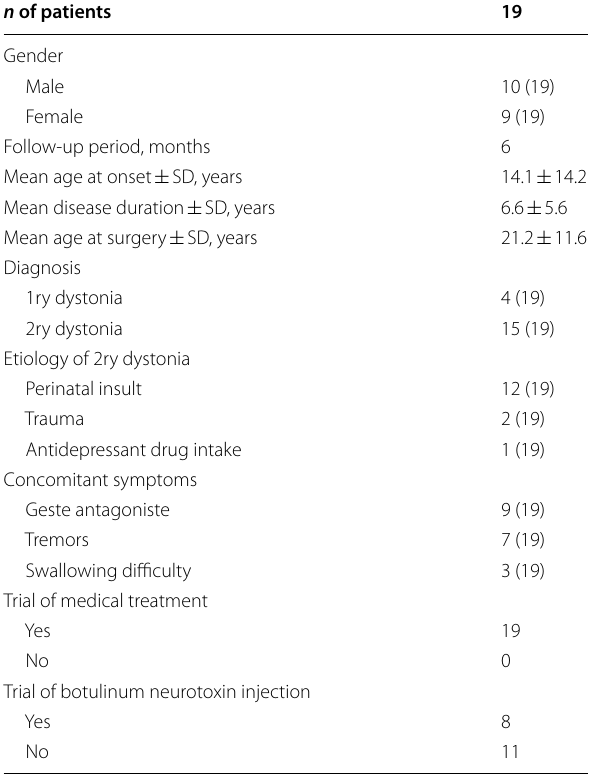
Table 3 Demographic and clinical characteristics of cervical dystonia patients